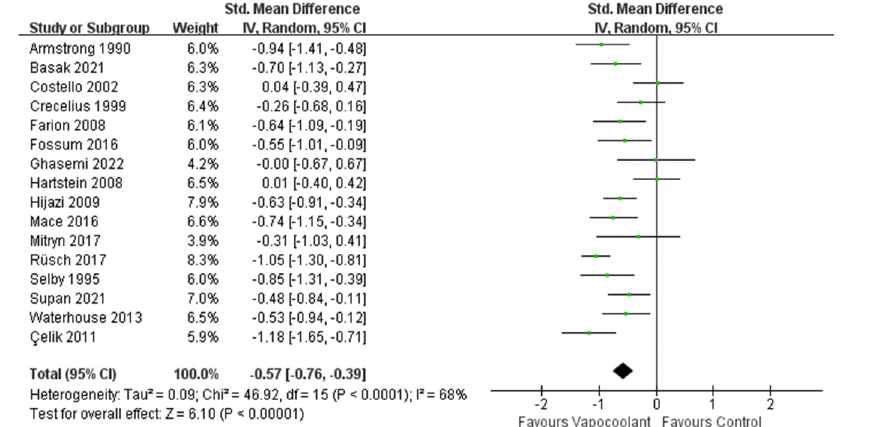
Fig 4. Forest plot of pain scores during intravenous cannulation.